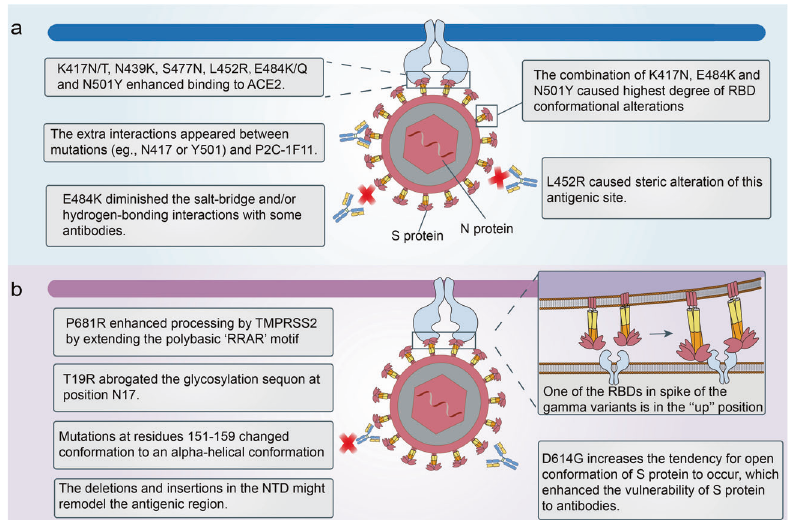
Fig. 1 Possible neutralization evasion mechanisms of severe acute respiratory syndrome coronavirus 2 (SARS-CoV-2) variants. a The mechanisms of mutations in the receptor-binding domain (RBD) to in fl uence the binding of spike protein to antibodies. b The mechanisms of mutations in an N-terminal domain (NTD) to in fl uence the binding of S protein to antibodies. Besides, the gamma variants adopted a conformation with one of RBDs in the “ up ” position, promoting binding to ACE2 and evasion of some